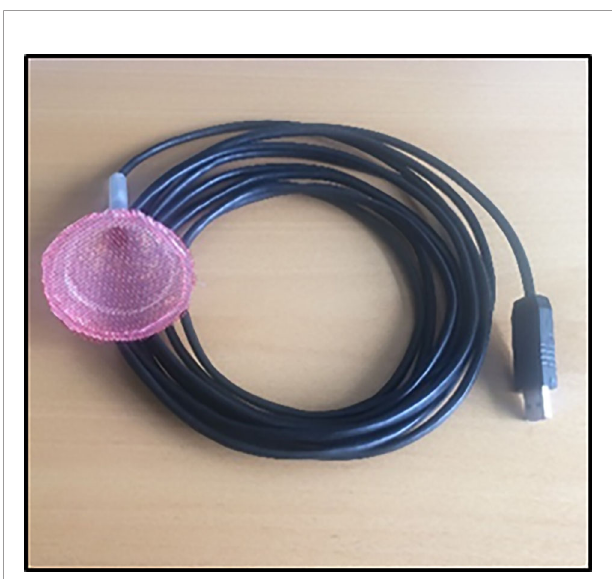
FIGURE 1 | Rootsnap sensor components. (A) Imaging device showing the lens with diameter of 7 mm; (B) entire endoscope with cable and usb connector; (C) frame component showing the funnel with diameter of 6.0 cm; (D) antiglare glass with diameter of 4.5 cm; (E) white nylon mesh with diameter of 6.5 cm; (F) red coloured nylon